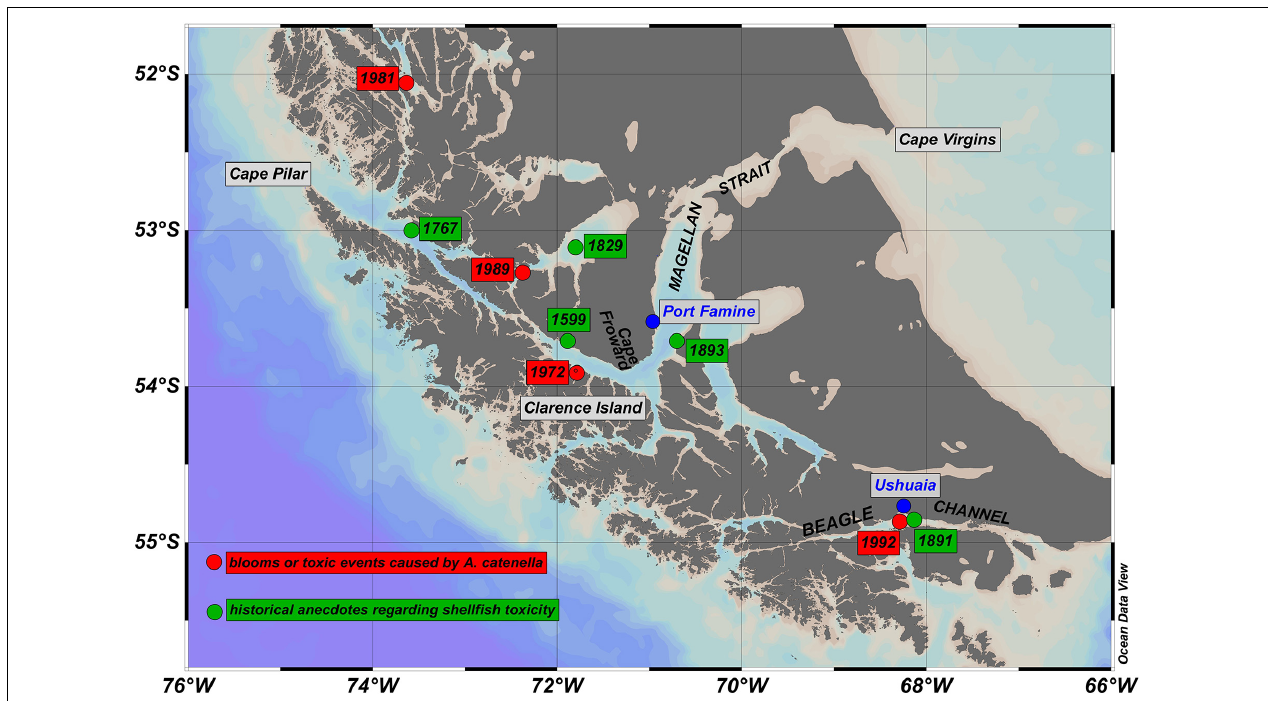
FIGURE 1 | Map of Magallanes and Tierra del Fuego regions of southern Chile and Argentina. The Magellan Strait and Beagle Channel directly connect the southern Pacific and Atlantic Oceans. Green dots show the approximate position of anecdotal reports of shellfish toxicity from pre-1900 historical sources. Accounts are reported (see text for details) for Cordes Bay, 1599 (Kerr, 1824), Cape Providence, 1767 (Hawkesworth, 1773), Englefield Island, 1829 (Fitzroy, 1839), Beagle Channel, 1891 (Segers, 1891), and Fuegian shore opposite Port Famine (O’Sullivan, 1893). Also shown in red are the approximate positions of the focal points of blooms of A. catenella and/or associated events of shellfish poisoning between the early 1970s and early 1990s. Events were centered on Bahia Bell, Clarence Island, 1972 (Guzmán et al., 1975a,b; Guzmán and Lembeye, 1975; Lembeye et al., 1975), Seno Union, 1981 (Lembeye, 1981a,b), Estero Núñez, 1989 (Uribe, 1988; Cited reference is given as 1988, even though the event was given as 1989), Beagle Channel, 1992 (Lembeye, 1992; Carreto and Benavides, 1993; Benavides et al., 1995). In all cases, blooms or shellfish toxicity were spread across a much wider area than indicated by the red dots (see also Figure 2